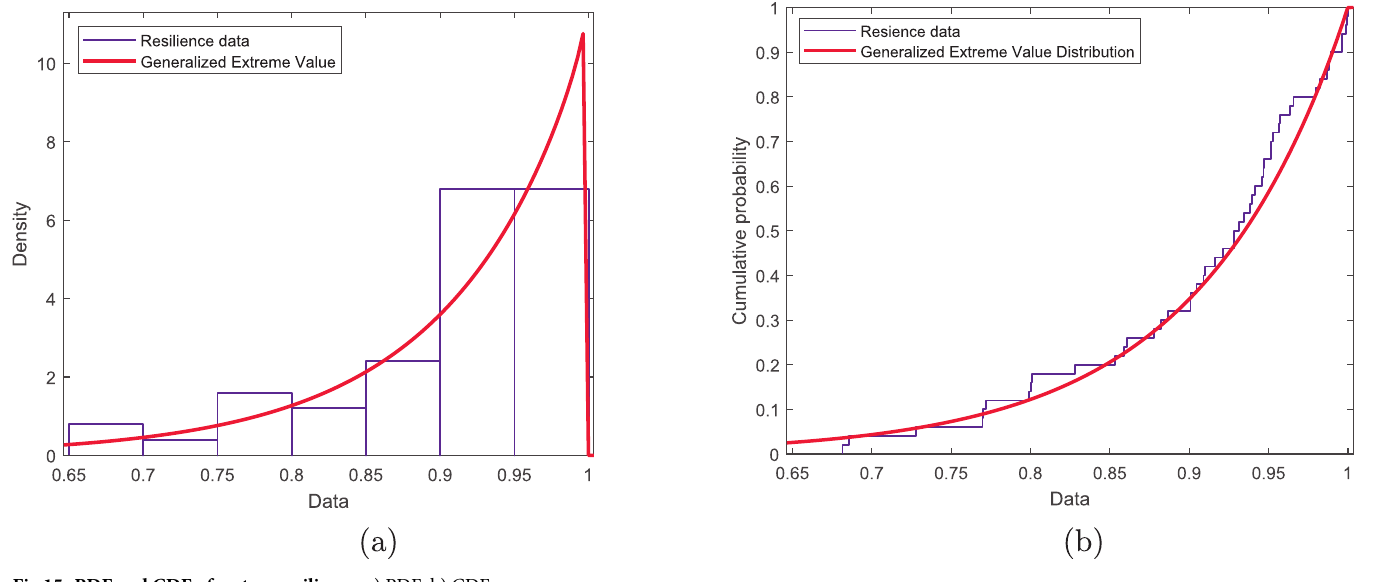
Fig 15. PDF and CDF of system resilience. a) PDF; b)